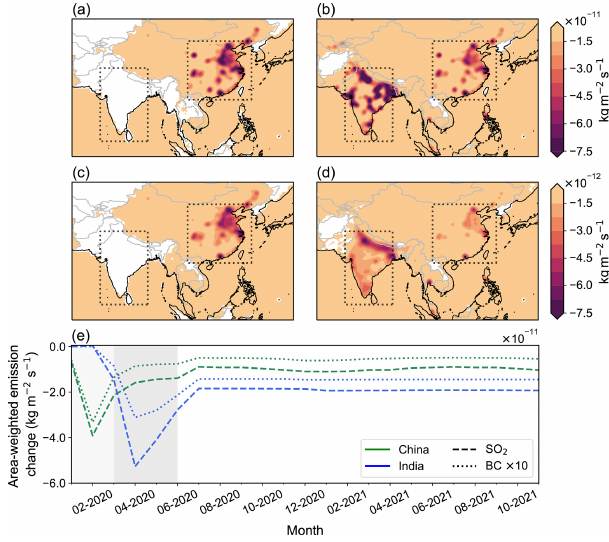
Figure 1. Changes in (a, b) SO 2 and (c, d) BC emissions over East and South Asia during JF 2020 (a, c) and MAM 2020 (b, d) . (e) Land-only, area-weighted changes in SO 2 and BC (scaled by a factor of 10) emissions from East China (21–42 ◦ N, 102–125 ◦ E) and India (6–32 ◦ N, 70–87 ◦ E), as defined in (a) – (d) . The JF and MAM 2020 periods used for later analysis are indicated by light- and dark-grey shading, respectively.